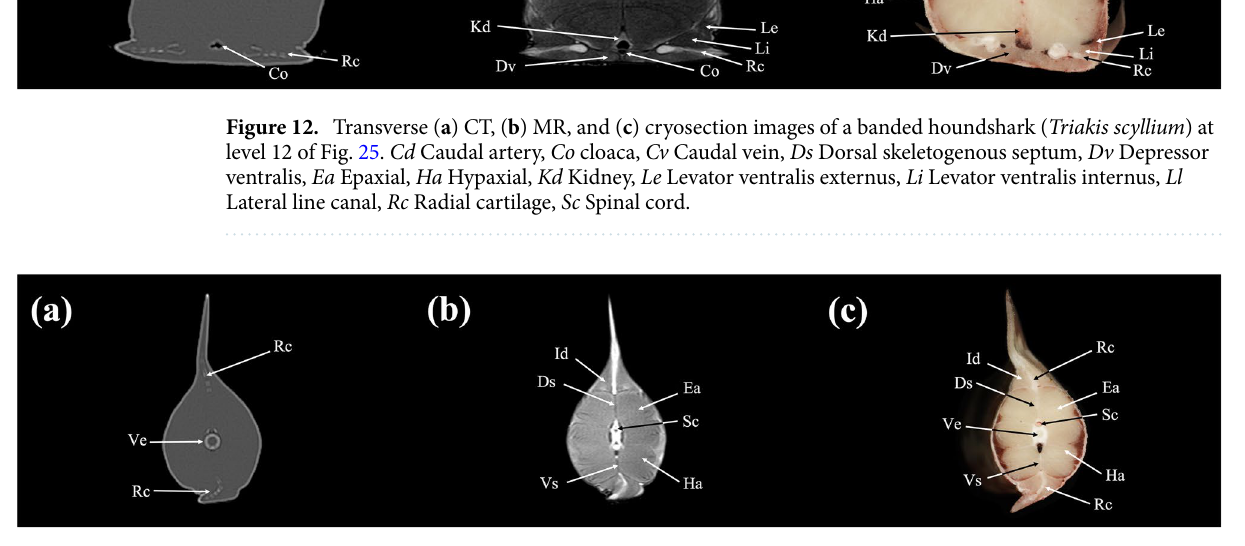
Figure 13. Transverse ( a ) CT, ( b ) MR, and ( c ) cryosection images of a banded houndshark ( Triakis scyllium ) at level 13 of Fig. 25. Ds Dorsal skeletogenous septum, Ea Epaxial, Ha Hypaxial, Id Inclinator dorsalis, Rc Radial cartilage, Sc Spinal cord, Ve Vertebra, Vs Ventral skeletogenous